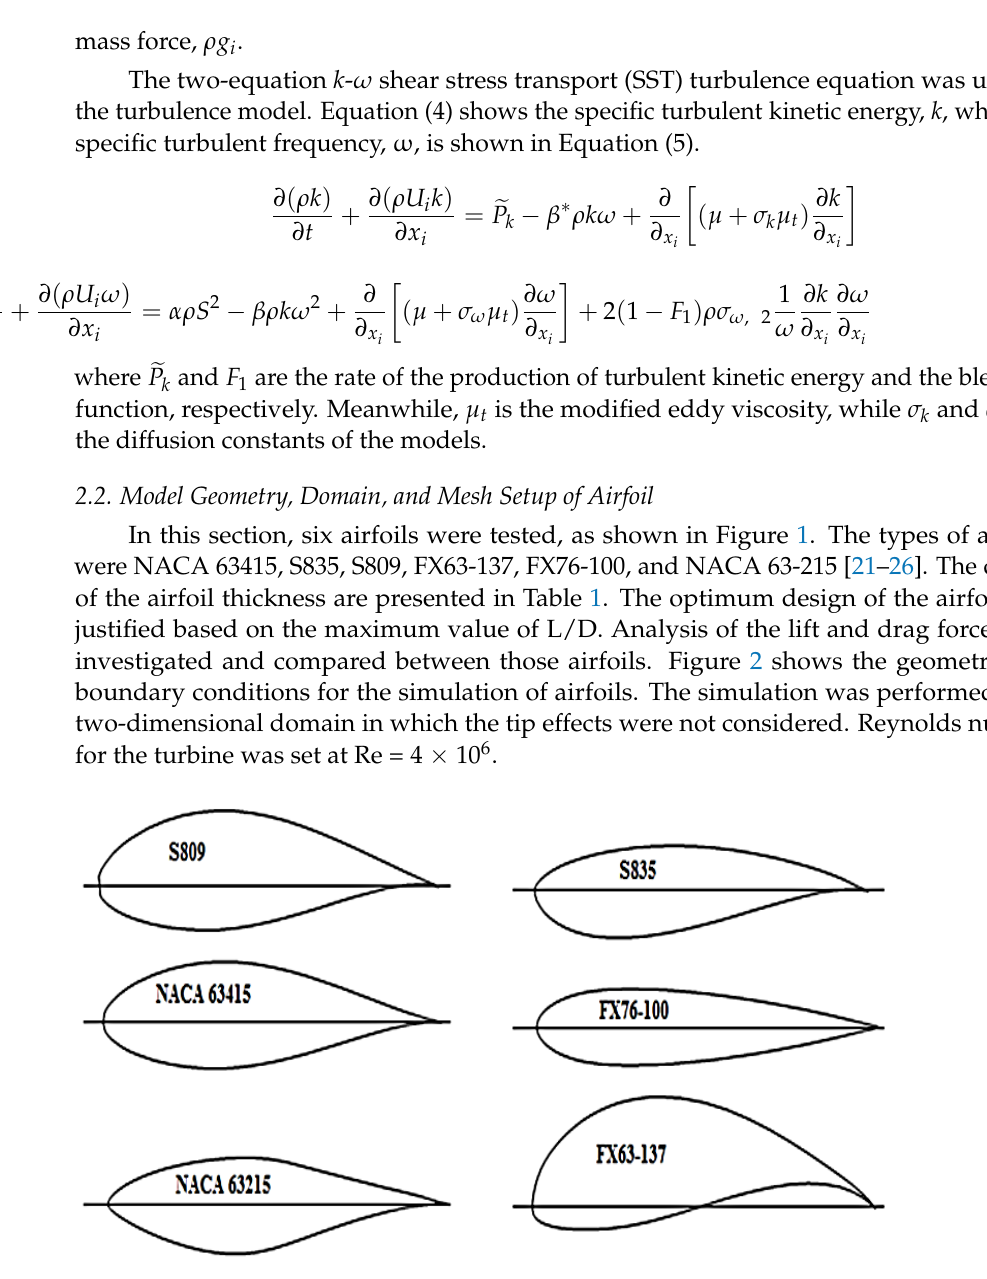
Figure 1. Airfoil Figure 1. Airfoil geometry.